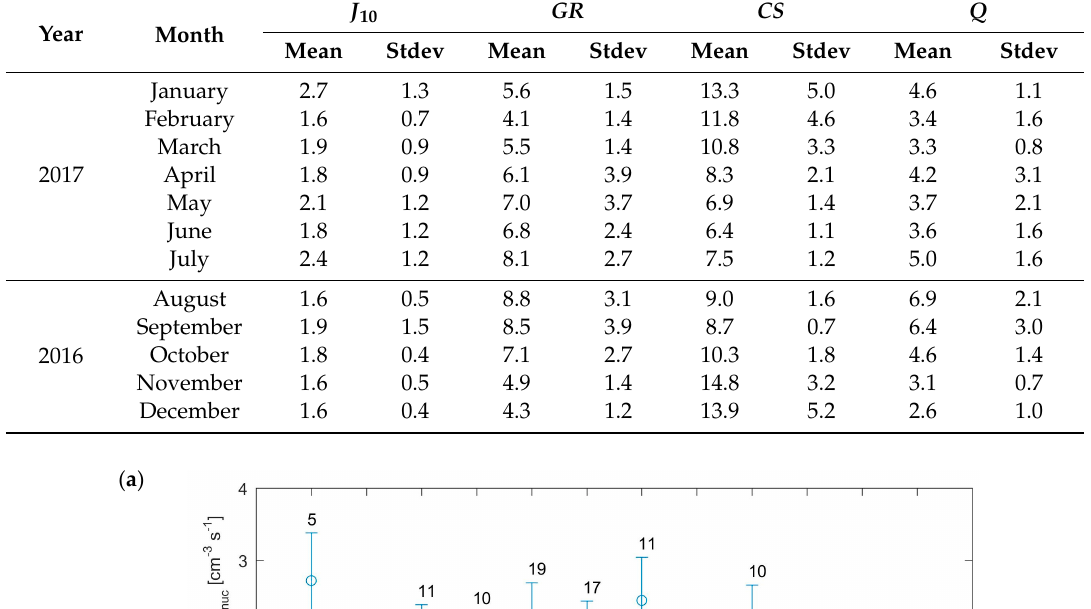
Table 2. Formation rate ( J 10 [particles/cm 3 s]), growth rate ( GR (nm/h)), condensation sink ( CS ( × 10 − 3